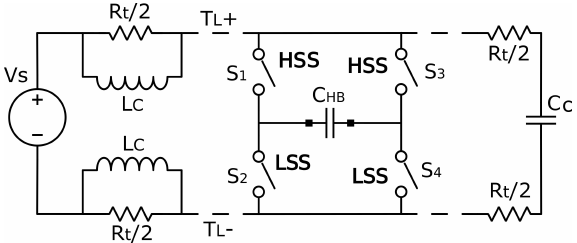
Figure 3. H-Bridge TX